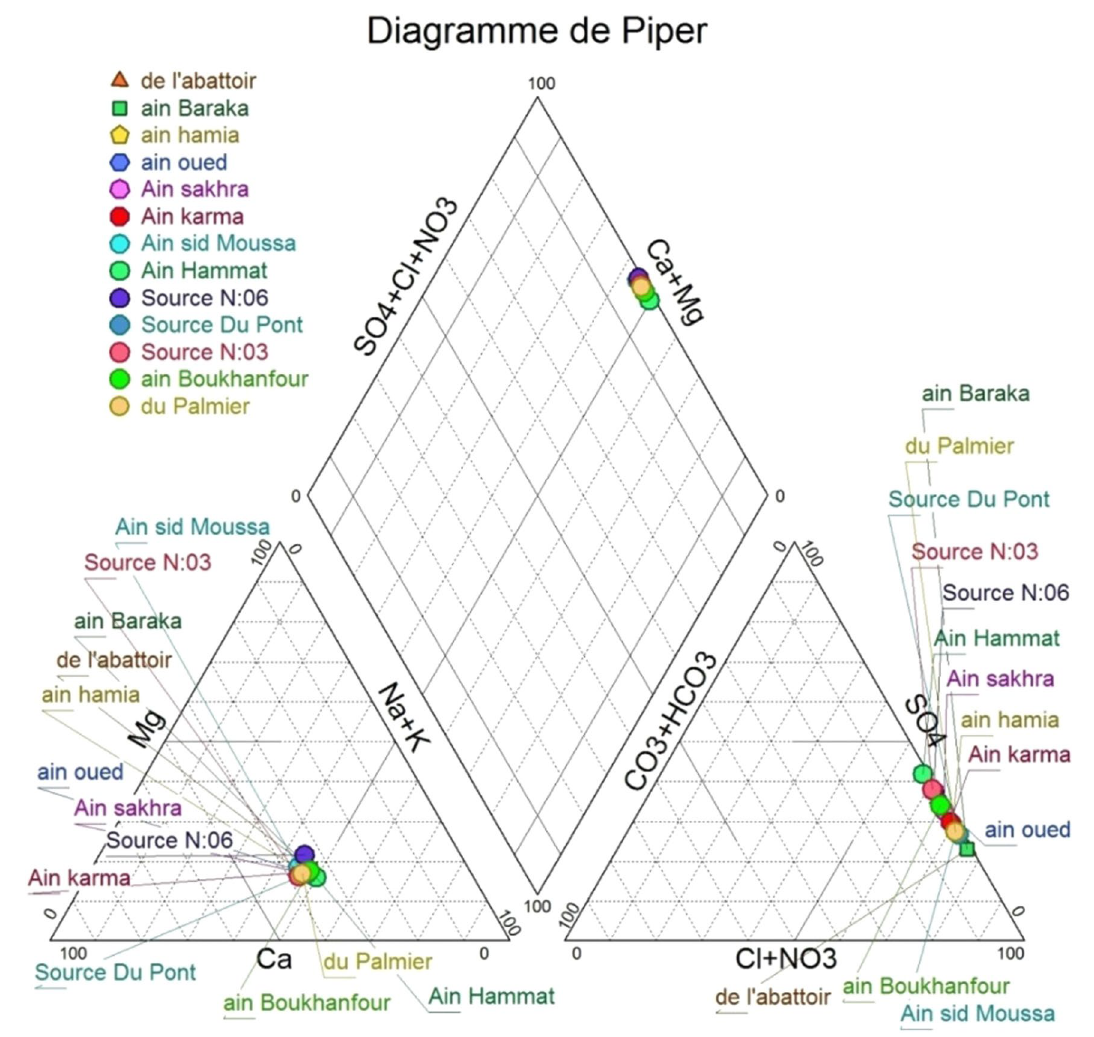
Fig. 5 Piper plot show the geochemical classification of water